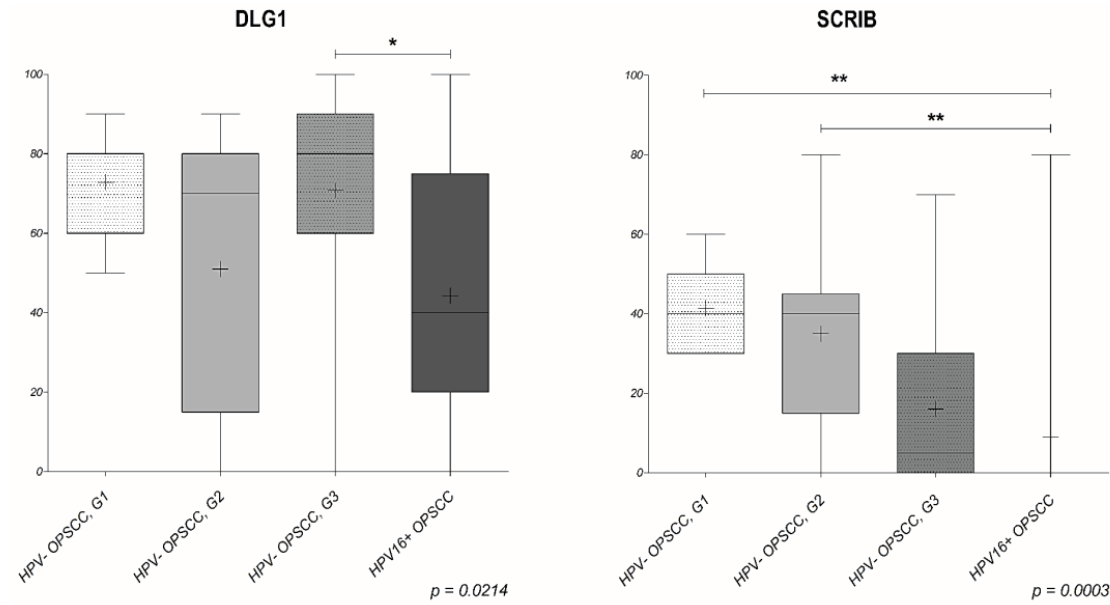
Figure 5. The ratio of DLG1- and SCRIB-positive staining in HPV-negative OPSCCs of various grades and HPV-positive OPSCCs. The score of DLG1 (I)- and SCRIB (II)-positive staining observed by pathologists was evaluated between HPV16- positive and HPV-negative OPSCCs grades 1–3 using the Kruskal–Wallis test with Dunn’s multiple comparison posttest. I. p -value (*) 0.0214, II. p -value (**) 0.0003.